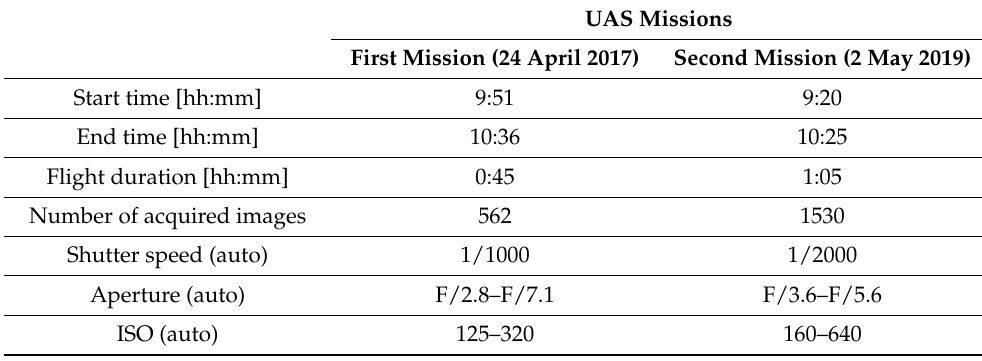
Table 4. Summary of accomplished missions with camera